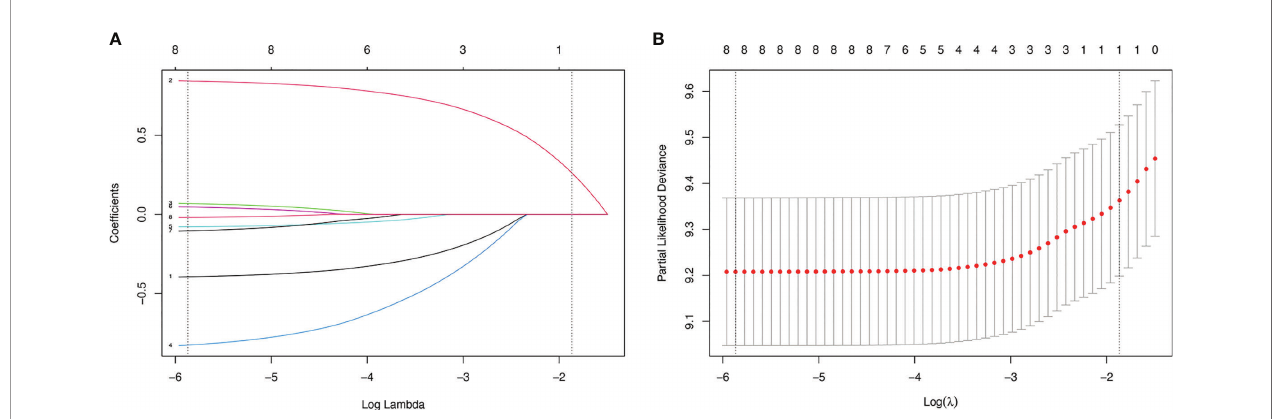
FIGURE 2 | LASSO regression model was used to select characteristic impact factors. (A) LASSO coef fi cients of 8 features; (B) Selection of tuning parameter ( l ) for